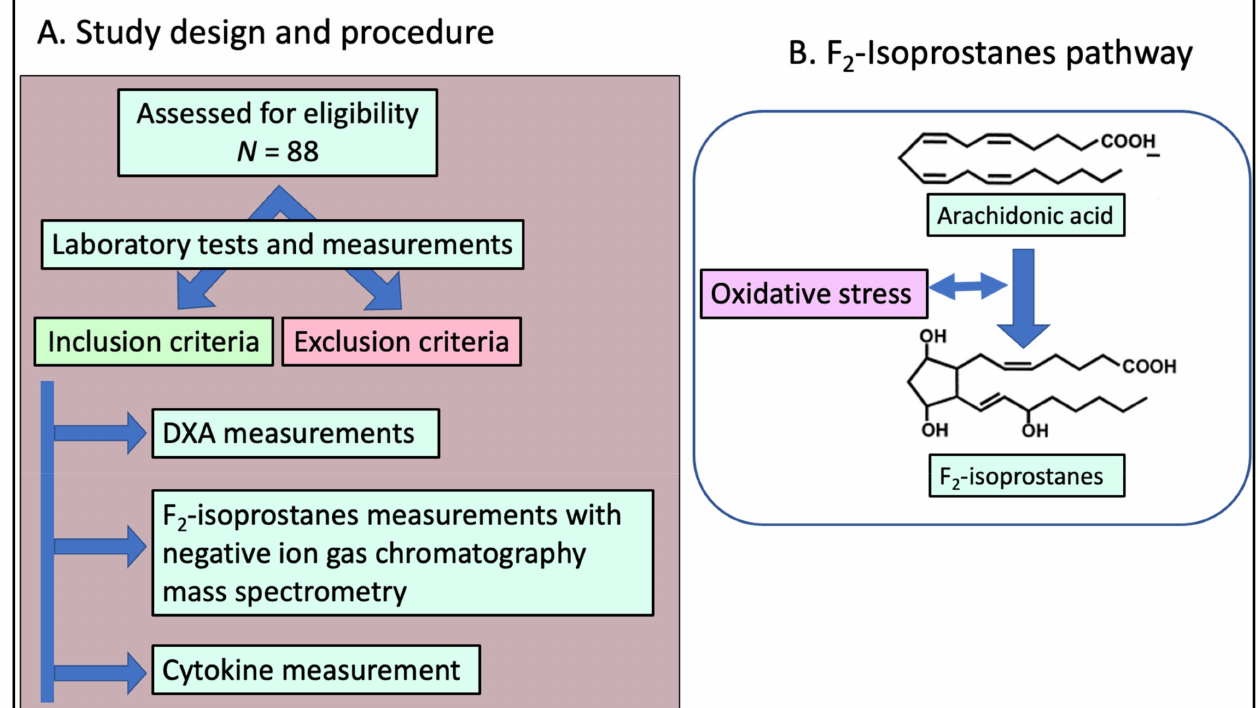
Figure 1. Study design and F 2 -IsoPs pathway. ( A ) Workflow of the study. This was an observational study. A total of 88 Black women were enrolled in the study. Laboratory tests and anthropometric measurements were performed to include or exclude the participants. ( B ) Depiction of F 2 -isoprostane synthesis